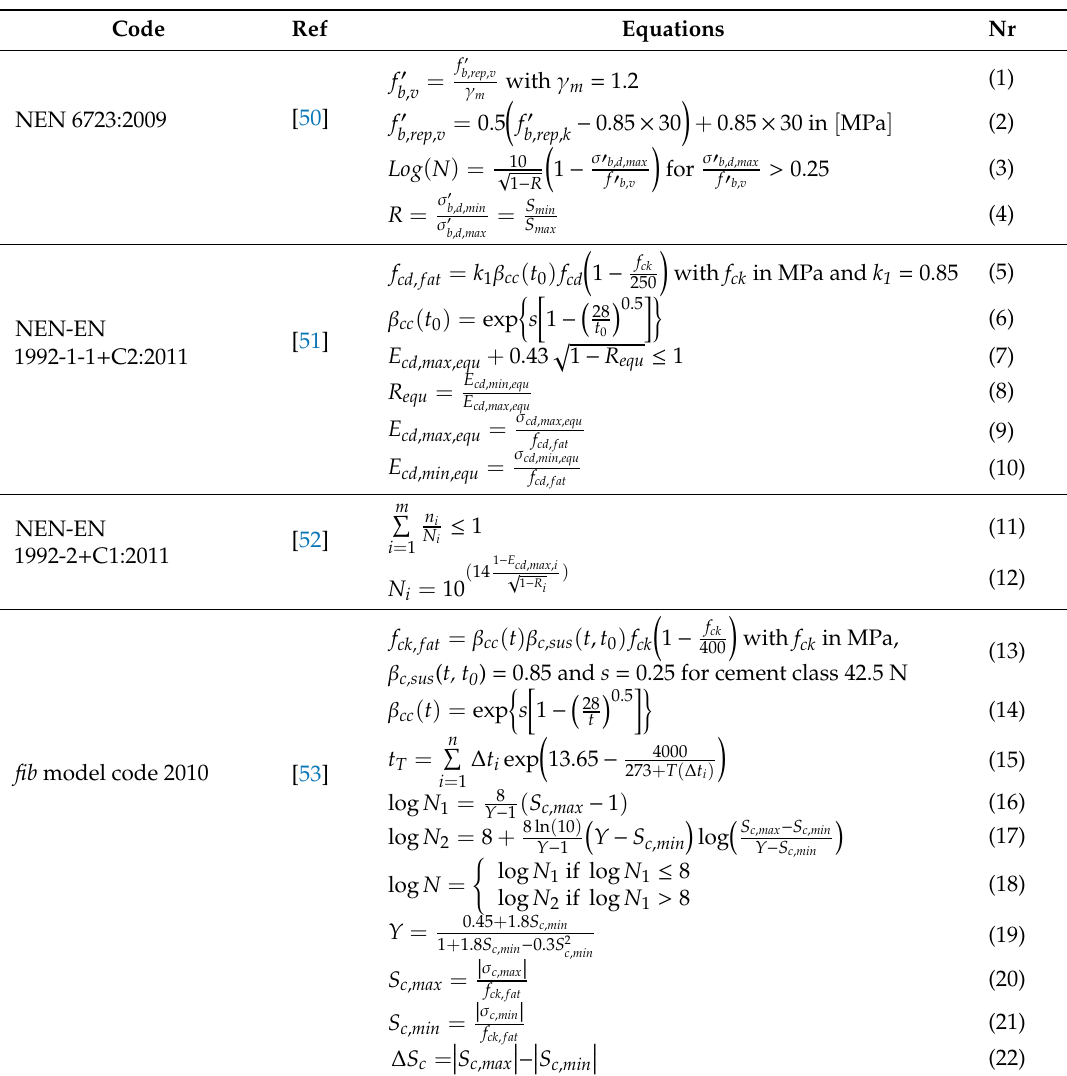
Table 1. Overview of code expressions for